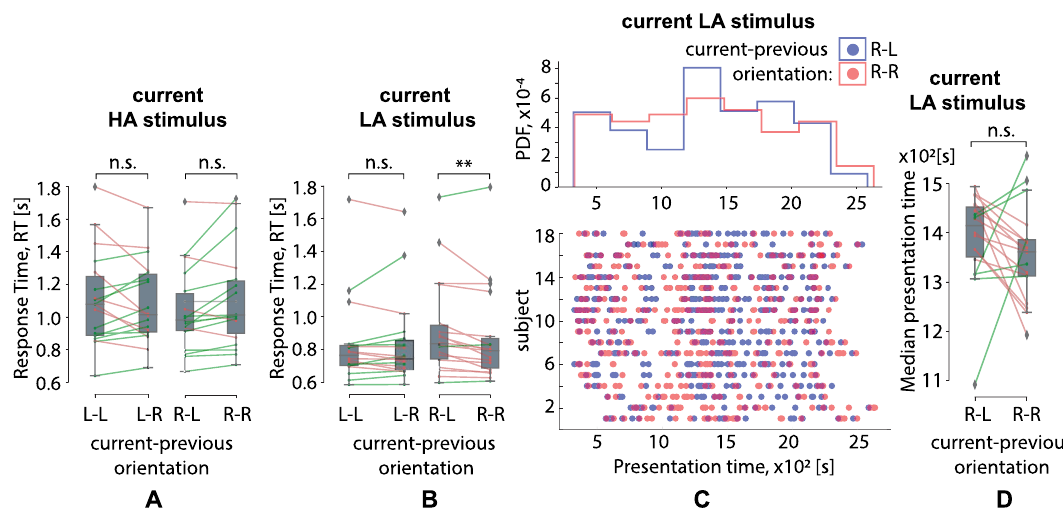
Figure 4. Effect of the previous stimulus orientation on RT to the current stimulus. Box-plot ( A ) illustrates median RT in the group of subjects to the left-oriented (L) and the right-oriented (R) HA stimuli depending on the orientation of the previous stimulus ( p > 0.05 , ANOVA). Box-plot ( B ) illustrates median RT for the left- oriented and the right-oriented LA stimuli depending on the previous stimulus’s orientation p = .005 ∗∗ . Dot- plot and histograms ( C ) show distributions of the presentation times for the right-oriented LA stimuli preceded by right-oriented (R-R) and left-oriented (R-L) stimuli. Box-plot (D) reflects the median presentation times of the right-oriented LA stimuli preceded by the right-oriented and the left-oriented stimuli, p = .337 LA stimuli followed the left-oriented (R-L) and the right-oriented (R-R) stimuli (Fig. 4C) and contrasted the median PT in these conditions (Fig. 4D). We found that PT varied from 3 × 10 2 s to 27 × 10 2 s. The median PT of the right-oriented LA stimuli followed the left-oriented stimuli (R-L) (M = 1389 s, SD = 95 ) did not differ from the median PT of the right-oriented LA stimuli followed the right-oriented stimuli (R-R) (M = 1356 s, SD = 95 ): t ( 17 ) = − .988, p = .337 (Fig. 4D). According to the Fig. 4D, the differences between some PTs pairs in R-R vs. R-L conditions are also large. Setting the threshold for the absolute PT difference ( (cid:31) PT) as 2.5 × 10 2 s,